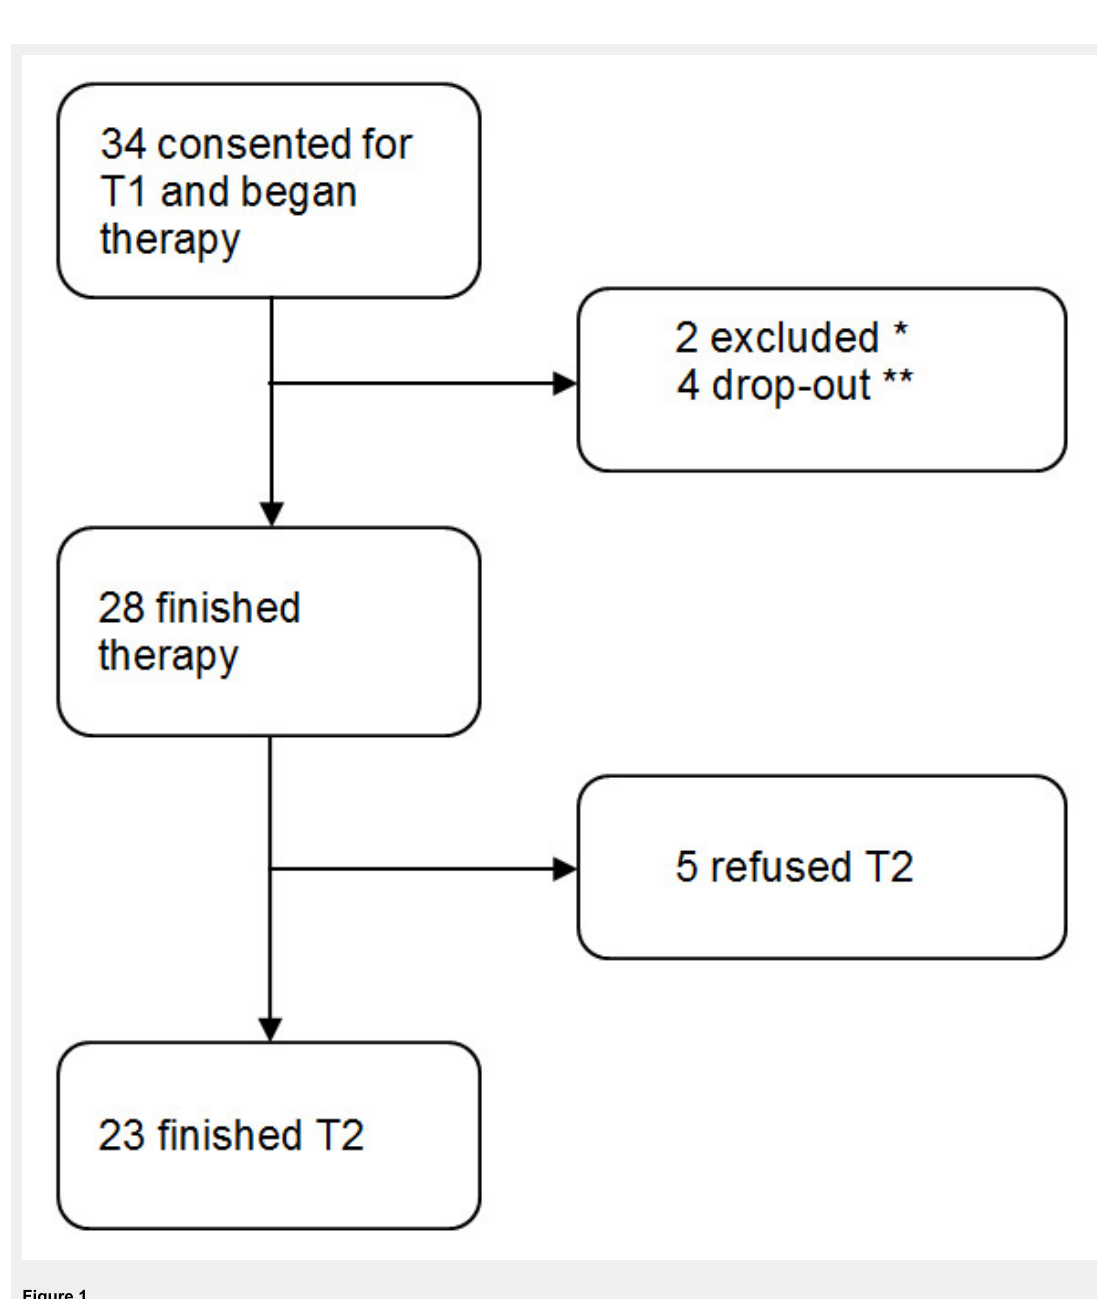
Participant rates at each stage of the trial. * Procedure bias: One woman consulted for her elder son and not her baby. The other woman had her T1 session after the first therapy session. ** All four stopped after the first session and refused T2. Two stopped because they already had another therapy in parallel, the two others did not give the